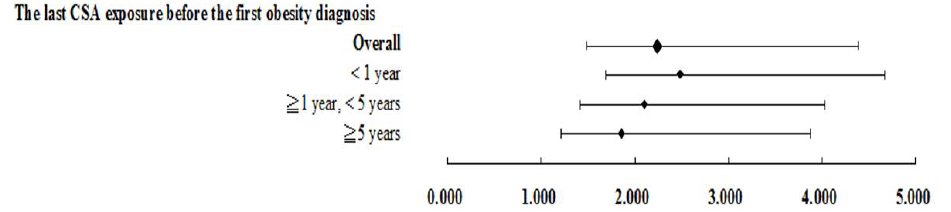
Figure 2. The last CSA exposure before the first obesity diagnosis.